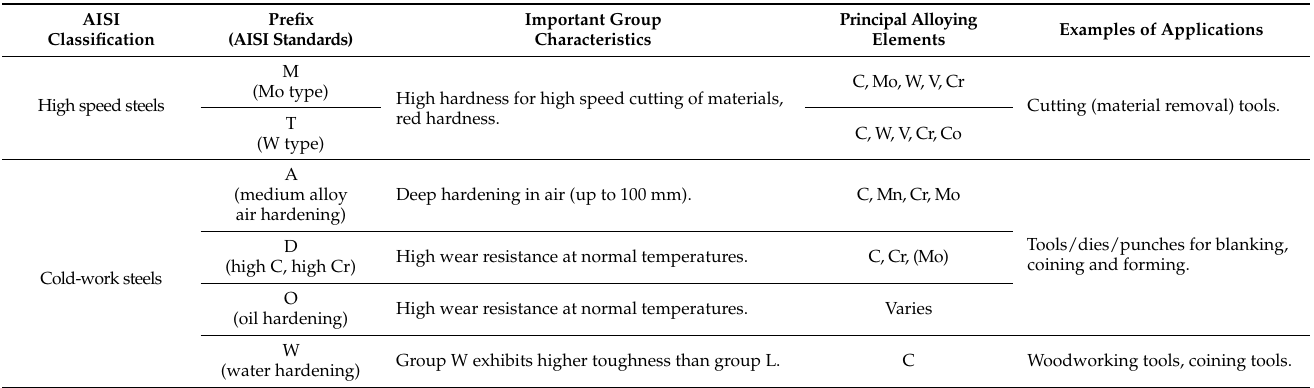
Table 3. AISI classification of (conventional) tool steels